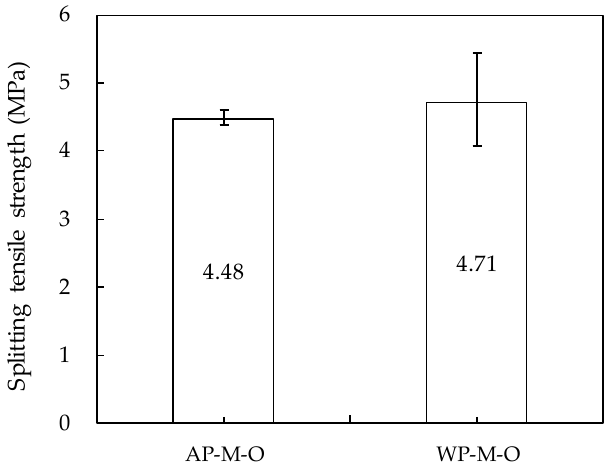
Figure 18. Splitting tensile strength.